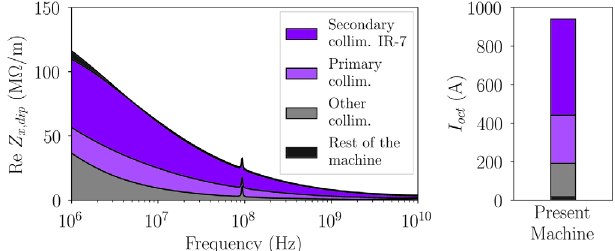
FIG. 2. LHC collimators dominate the overall machine imped- ance at the top energy (plotted on the left — real part of the dipolar impedance as a function of frequency). They are responsible for nearly all the octupole current required to stabilize the beam, with ∼ 50% coming from 11 secondary betatron cleaning collimators (plotted on the right — estimated octupole threshold with a factor 2 included, details of the simulation can be found in Sec. III). scenario [27], the most critical, horizontal plane is shown.